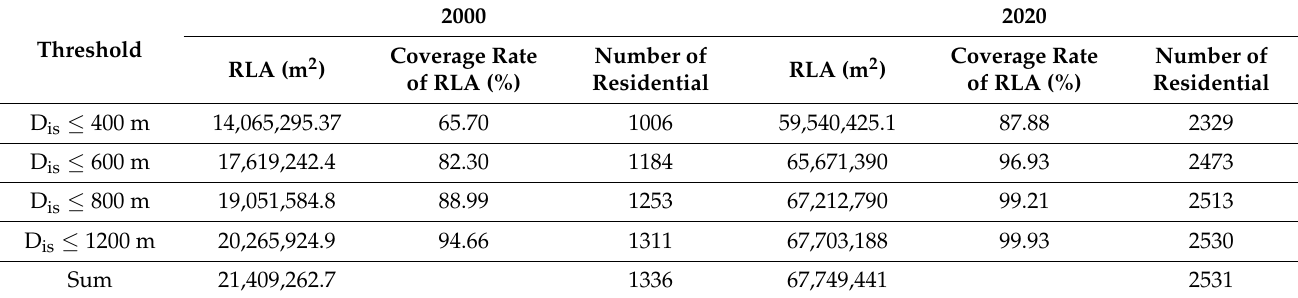
Table 4. Coverage rate of residential land area (RLA) within a threshold from the stop.